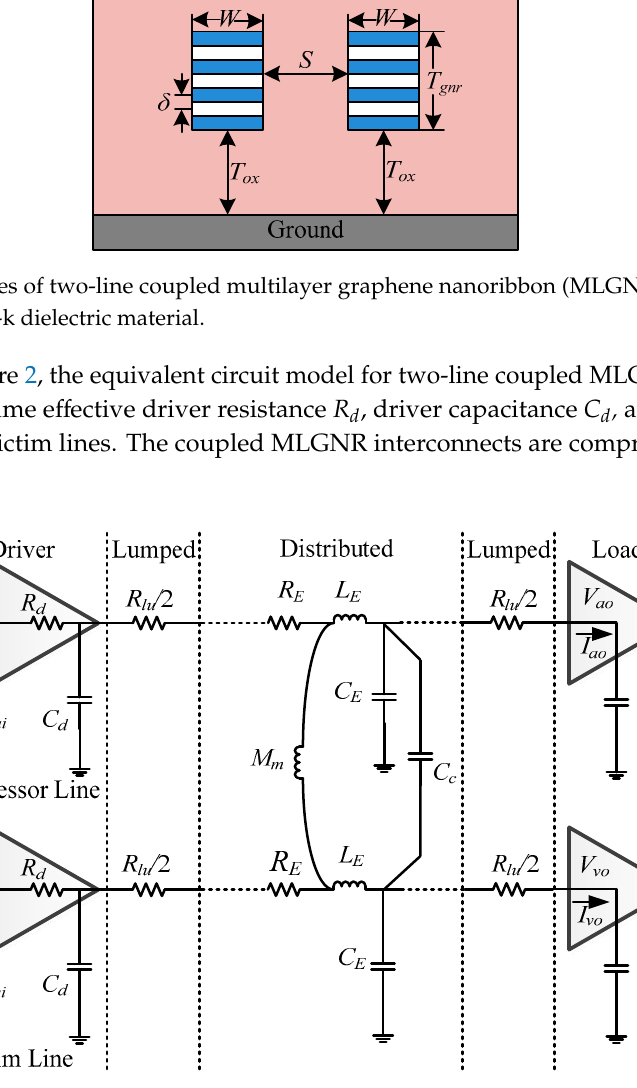
Figure 2. The equivalent circuit model of two-line coupled MLGNR interconnects.